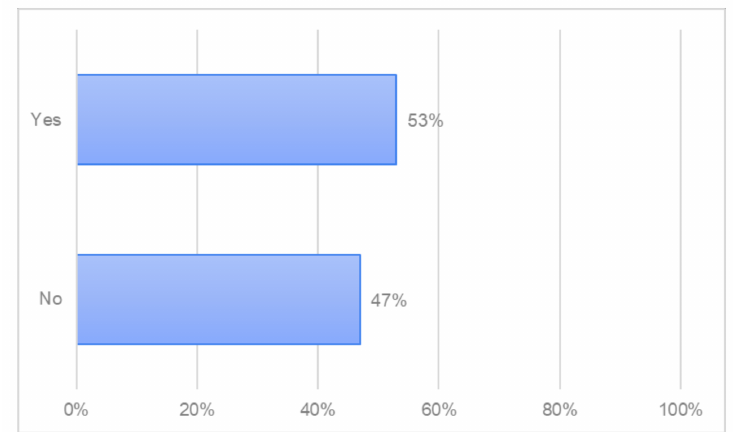
Figure 1. The number of tree climbers working minimally in a pair.